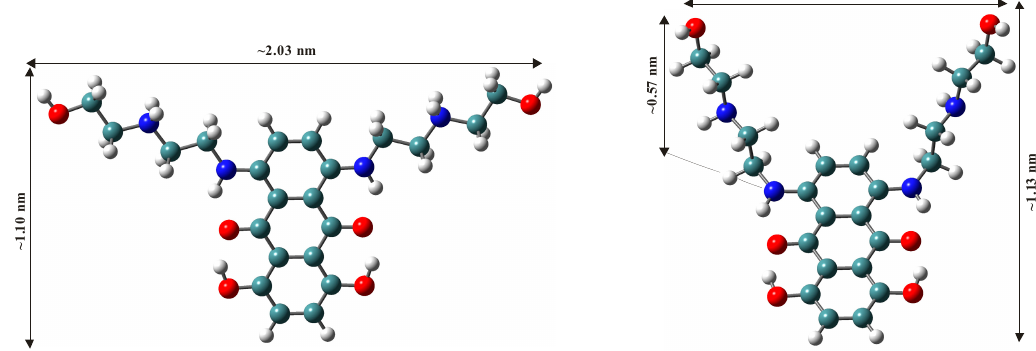
Figure 2. Optimized geometries of mitoxantrone monomer in neutral form ( right ) and dication form ( left ).